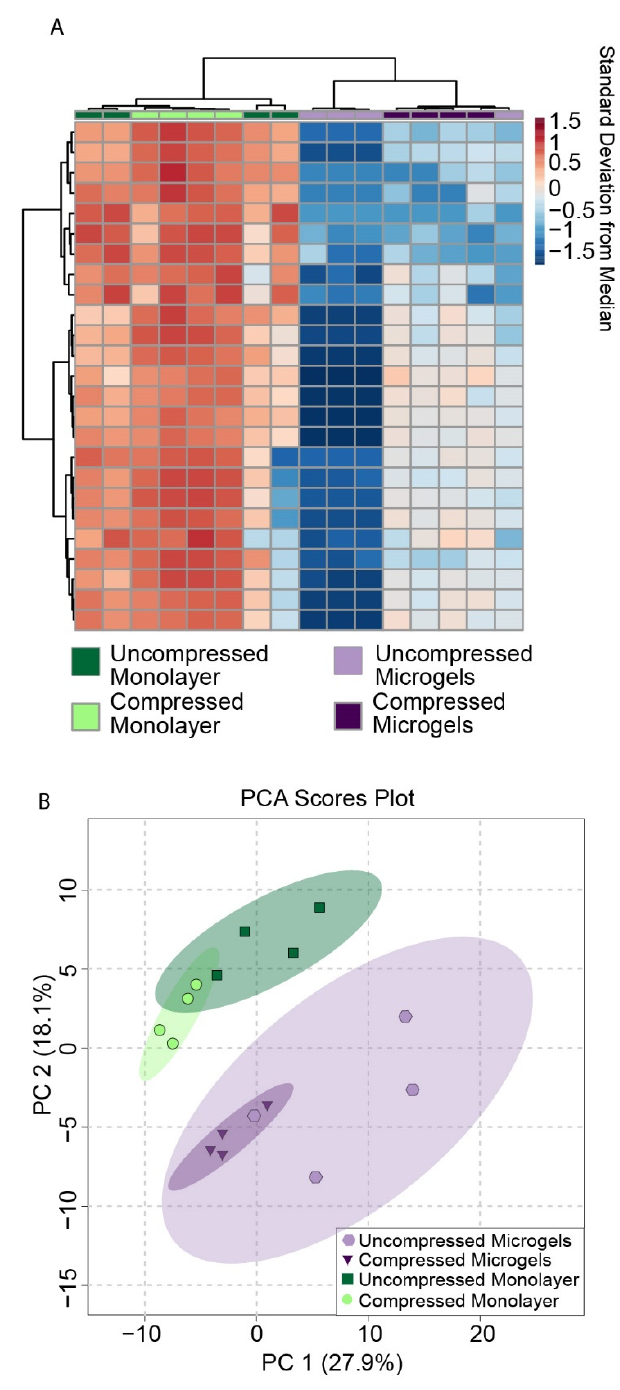
Figure 4. ( A ) Heat map of top 25 metabolites from SW1353 cells. ( B ) Two-dimensional score plot of PCA analysis for metabolites from SW1353 cells cultured with complete media supplemented with 50 µ g/mL L-sodium ascorbate.